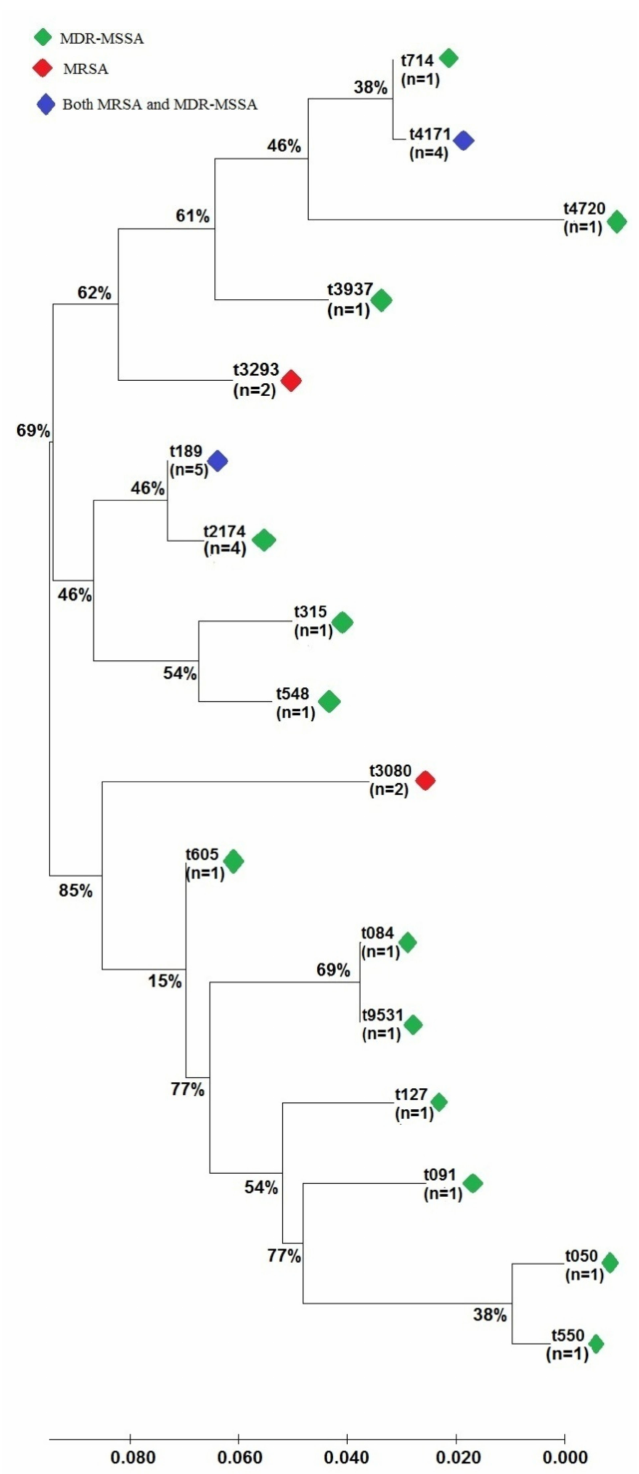
Figure 2. The phylogenetic tree of the spa types of MDRSA isolates was constructed using MEGA version 10. The evolutionary history was inferred using the neighbor-joining method. The optimal tree with the sum of the branch length = 0.45581958 is shown. The tree is drawn to scale, with branch lengths in the same units as those of the evolutionary distances used to infer the phylogenetic tree. The evolutionary distances were computed using the maximum composite likelihood method and are in the units of the number of base substitutions per